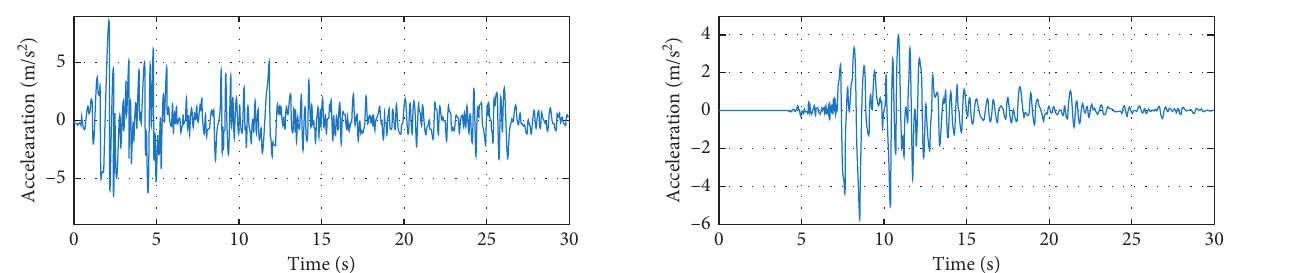
Figure 20: The scaled El-centro earthquake accelerations. Figure 21: The scaled Kobe earthquake